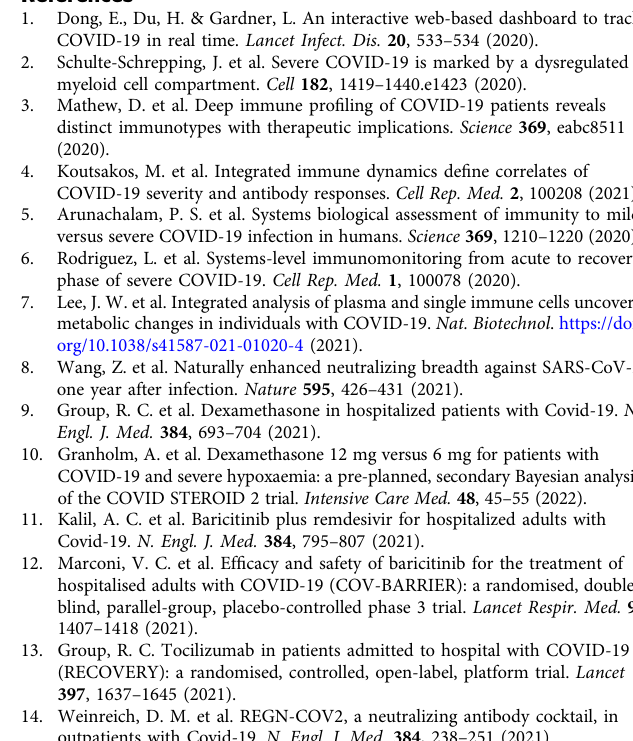
following links: Fig. 2 Data: https:// fl owrepository.org/experiments/4853 ID: FR-FCM- Z4NL) Fig. 4 Data: https:// fl owrepository.org/experiments/4854 (ID: FR-FCM-Z4NM) Supplementary Figs. 1 – 4 Data: https:// fl owrepository.org/experiments/4857 (ID: FR- FCM-Z4NP). All other data are available in the article and its Supplementary fi les